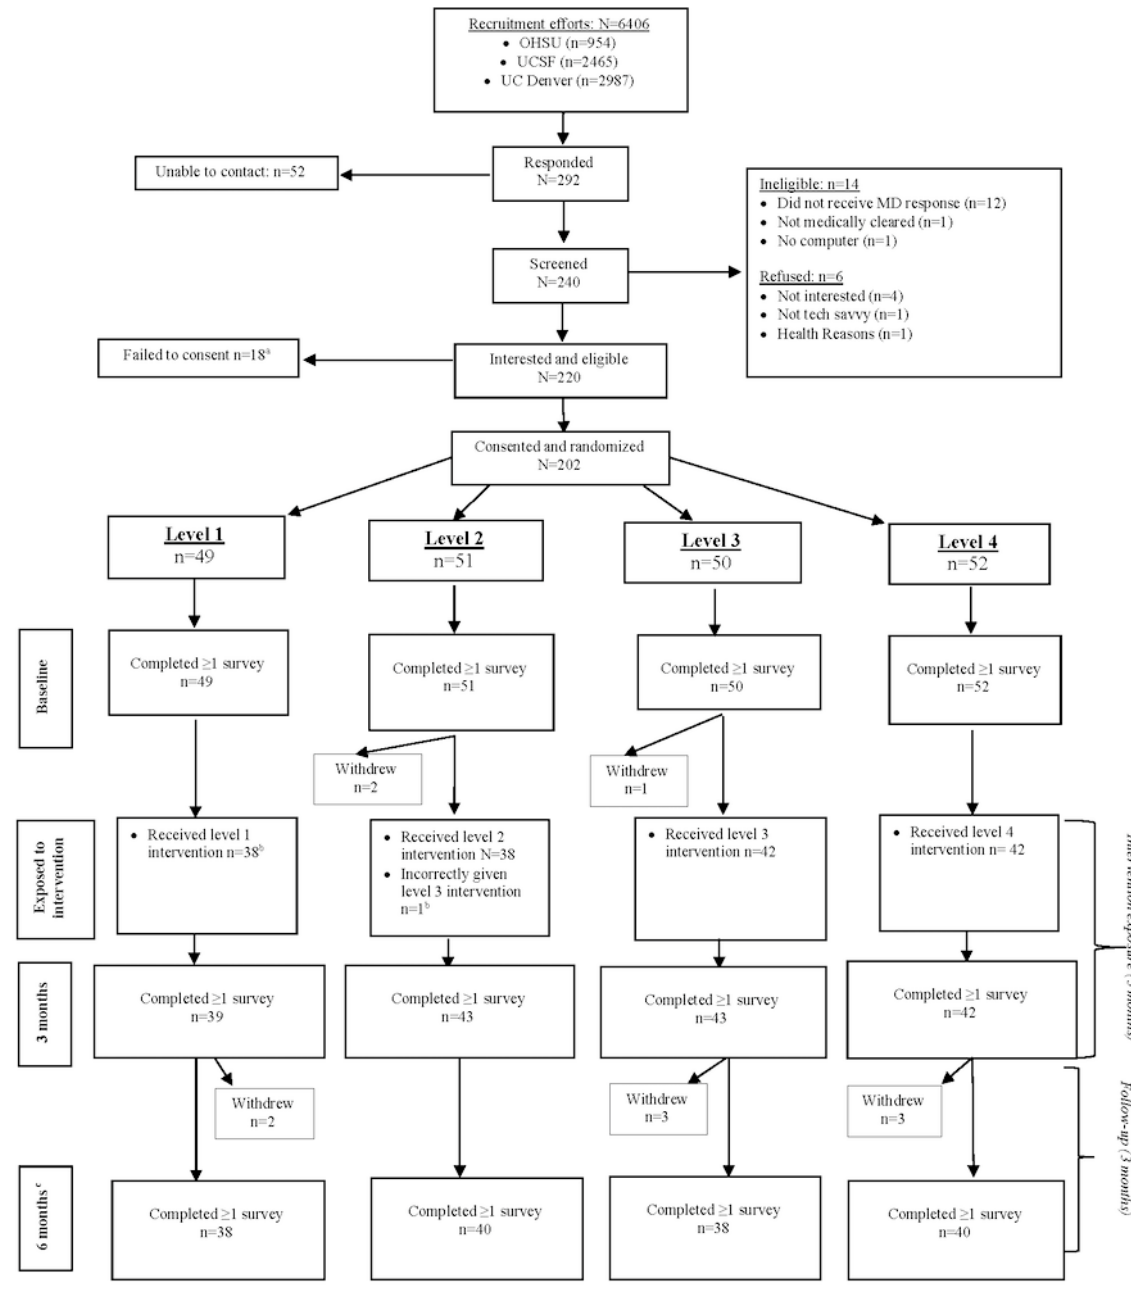
Figure 1. Consolidated Standards of Reporting Trials (CONSORT) diagram showing the flow of participants from screening through end of